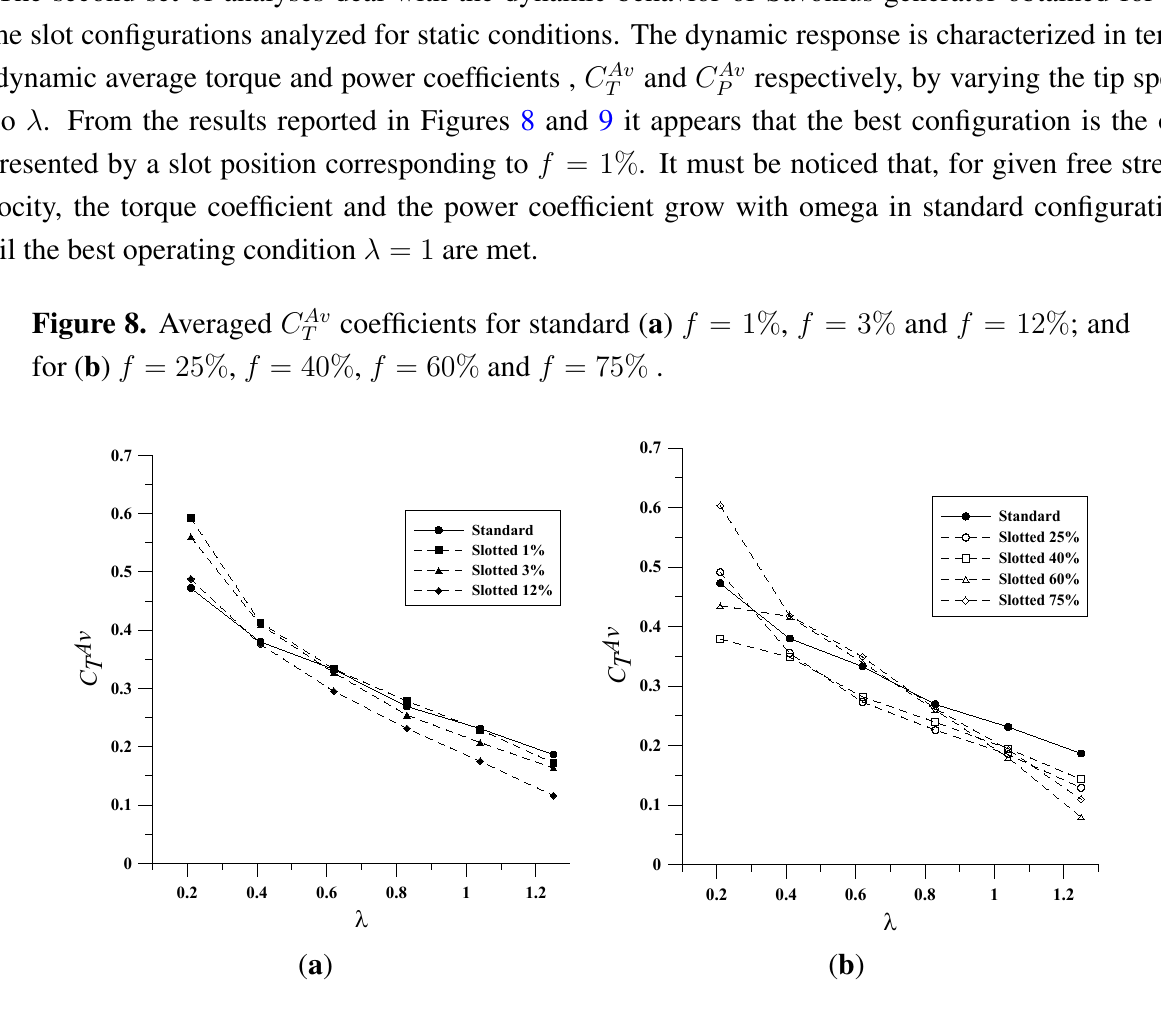
Figure 9. Averaged C Av coefficients for standard ( a ) f = 1% , f = 3% and f = 12% ; and P for ( b ) f = 25% , f = 40% , f = 60% and f = 75%